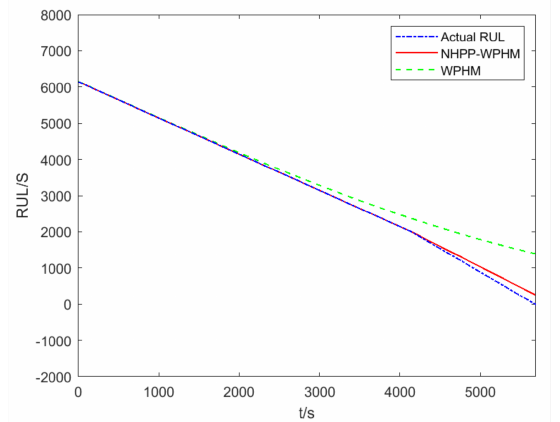
Figure 11. RUL prediction results of two models.